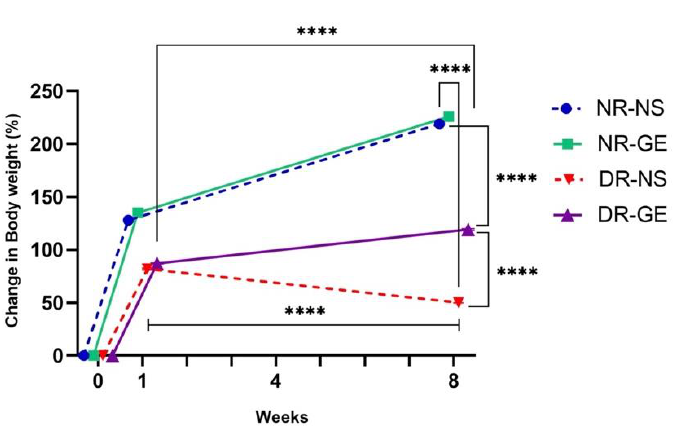
Figure 1. Percentage changes in bodyweight levels for all rat groups after 1 and 8 weeks of GE treatment. ****: p ≤ 0.001.